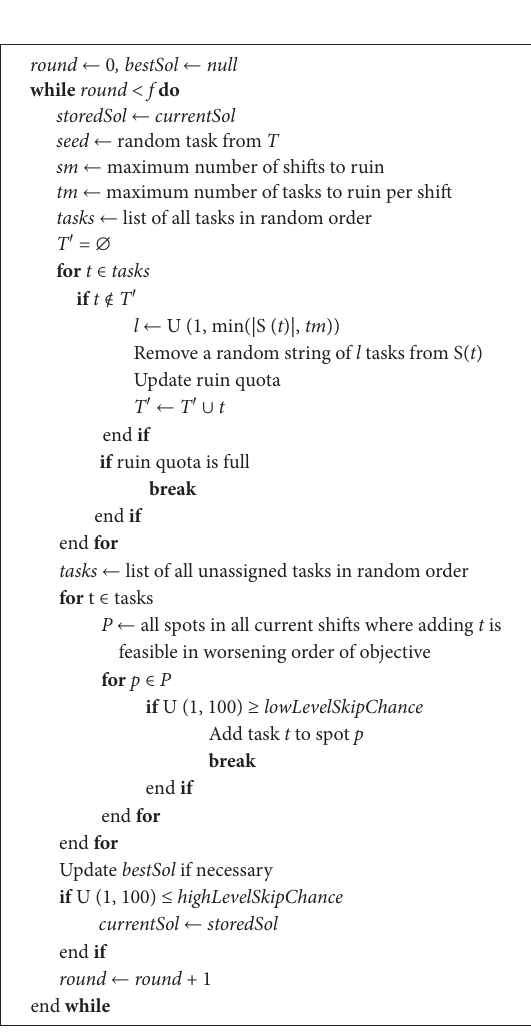
Figure 2: The pseudocode of the ruin and recreate